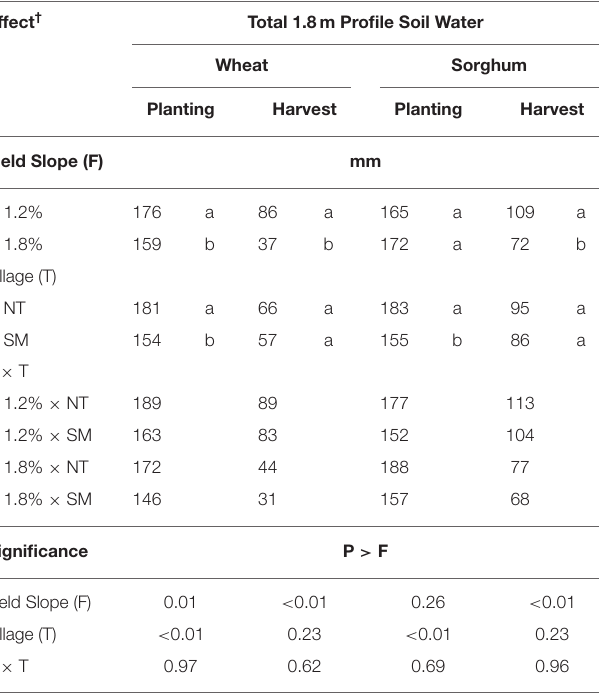
TABLE 3 | Mean grain yield, kg ha − 1 , and water use, mm, of wheat and sorghum crops in relation to the field slope, tillage, and interaction effects with the corresponding ANOVA significance